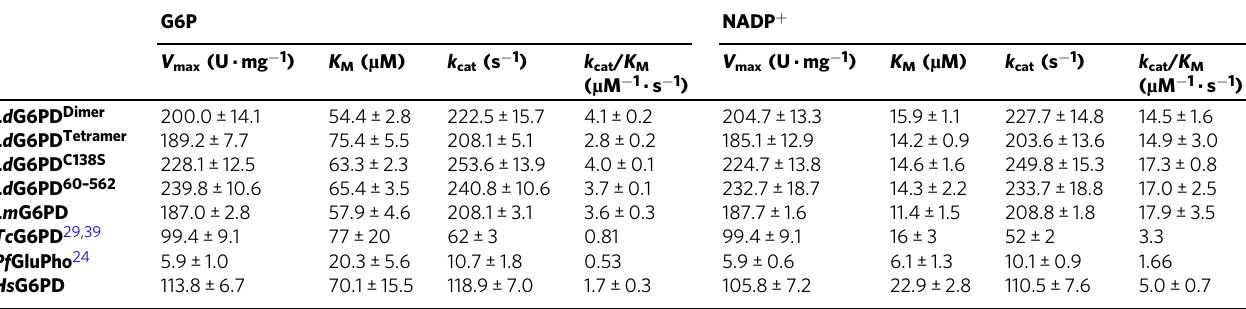
Table 1 Comparative kinetic parameters of recombinant Ld G6PD wt and mutants, Lm G6PD, Tc G6PD, Pf GluPho, and Hs G6PD. G6P NADP